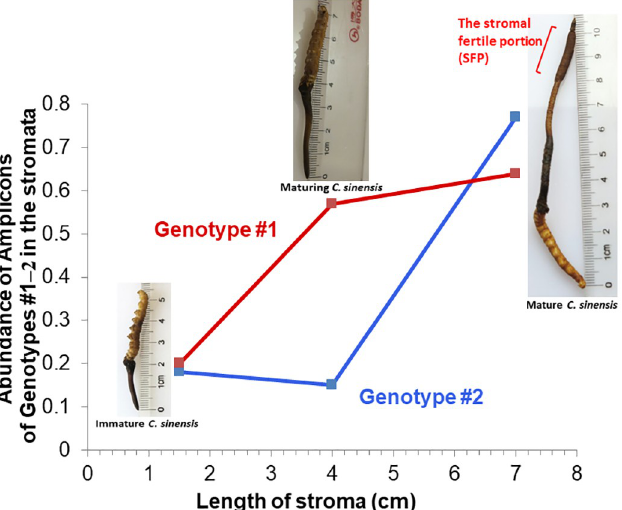
Fig 8. Dynamic alterations of the abundance of the amplicons of Genotypes #1 and #2 of O . sinensis in the stromata of C . sinensis during maturation (modified from Fig 6 of [28]). Immature C . sinensis had very short stroma of 1.5 cm. Maturing C . sinensis had stroma of 4.0 cm without an expanded fertile portion close to the stroma tip. Mature C . sinensis had long stroma of 7.0 cm and showed the formation of an expanded fertile portion close to the stroma tip, which was densely covered with